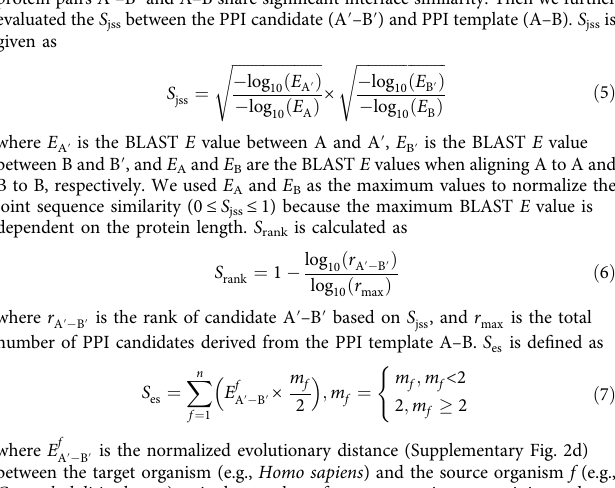
ffiffiffiffiffiffiffiffiffiffiffiffiffiffiffiffiffiffiffiffiffiffiffi (cid:3) log